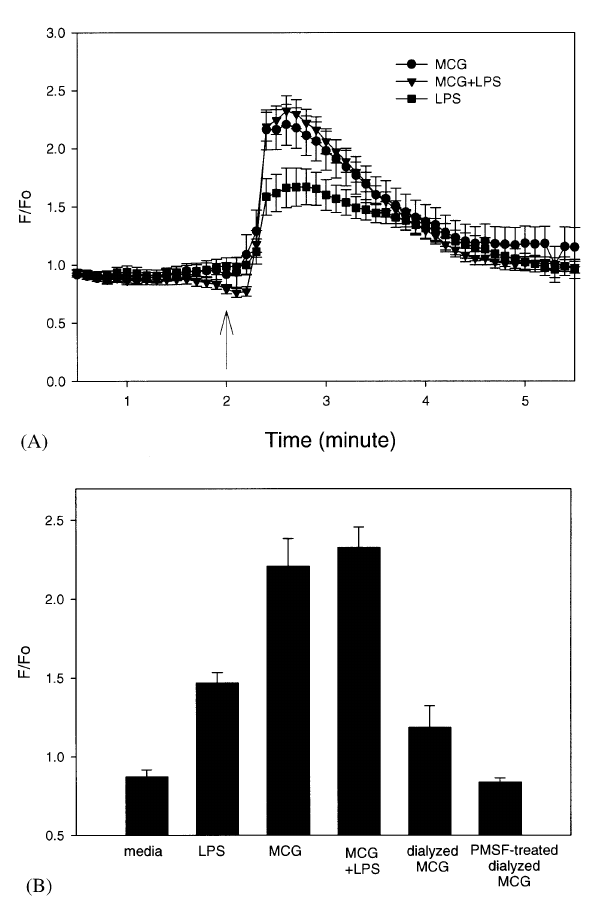
FIG. 2. (A) Time course of MCG-induced and LPS-induced intracellular Ca 2 (cid:2) levels. Fluo-4-labeled HUVECs (6 (cid:5) / 10 5 ) were monitored with confocal microscopy during stimula- tion with LPS (100 ng/ml), MCG (3 (cid:5) / 10 5 mast cell equiva- lents), and a combination of both agonists (applied at the arrow). The data are plotted as F/F o as described in the Materials and methods section. The fluorescence values (indicating free intracellular Ca 2 (cid:2) ) increased after the addi- tion of each agonist. Each data point represents the mean 9 / standard error of the mean. This is representative of three experiments. (B) MCG-induced and LPS-induced peak tran- sient changes in intracellular Ca 2 (cid:2) levels. Peak Ca 2 (cid:2)